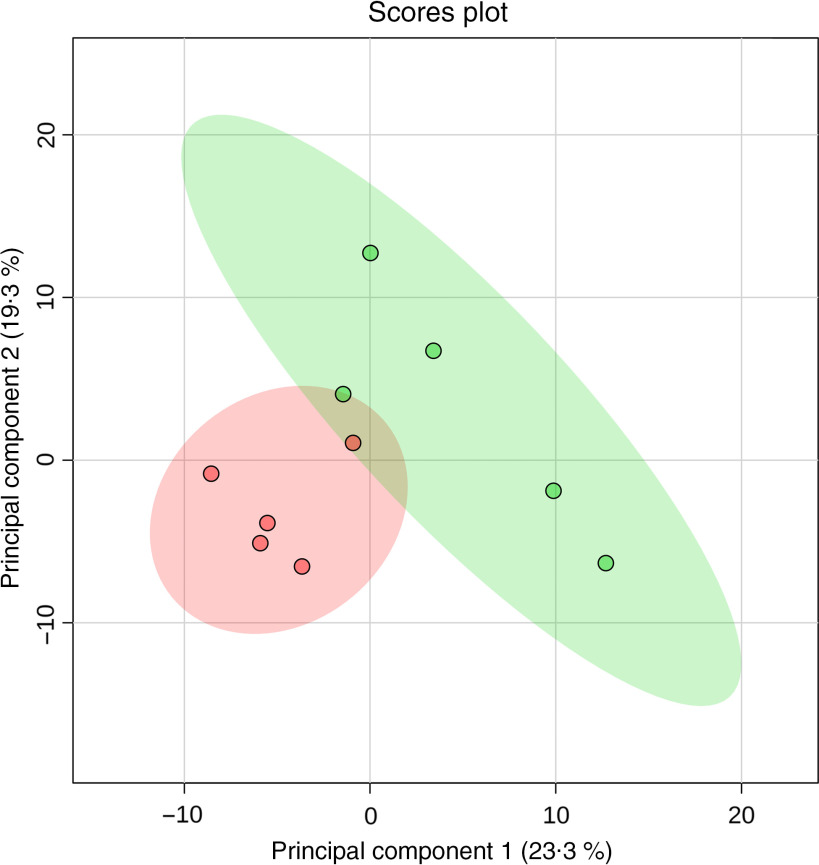
Two-dimensional score plots of principal component analysis of hepatic metabolites in post-weaning piglets on day 7 post-diquat challenge. Confidence ranges of 95 % are depicted as circled areas. Numbers listed in parentheses of each principal component indicate the variance explained. Dots indicate individual samples from the NC or PC group (n 5), respectively. , Negative control without diquat challenge or dietary selenium supplementation; , positive control with diquat challenge without dietary selenium supplementation.